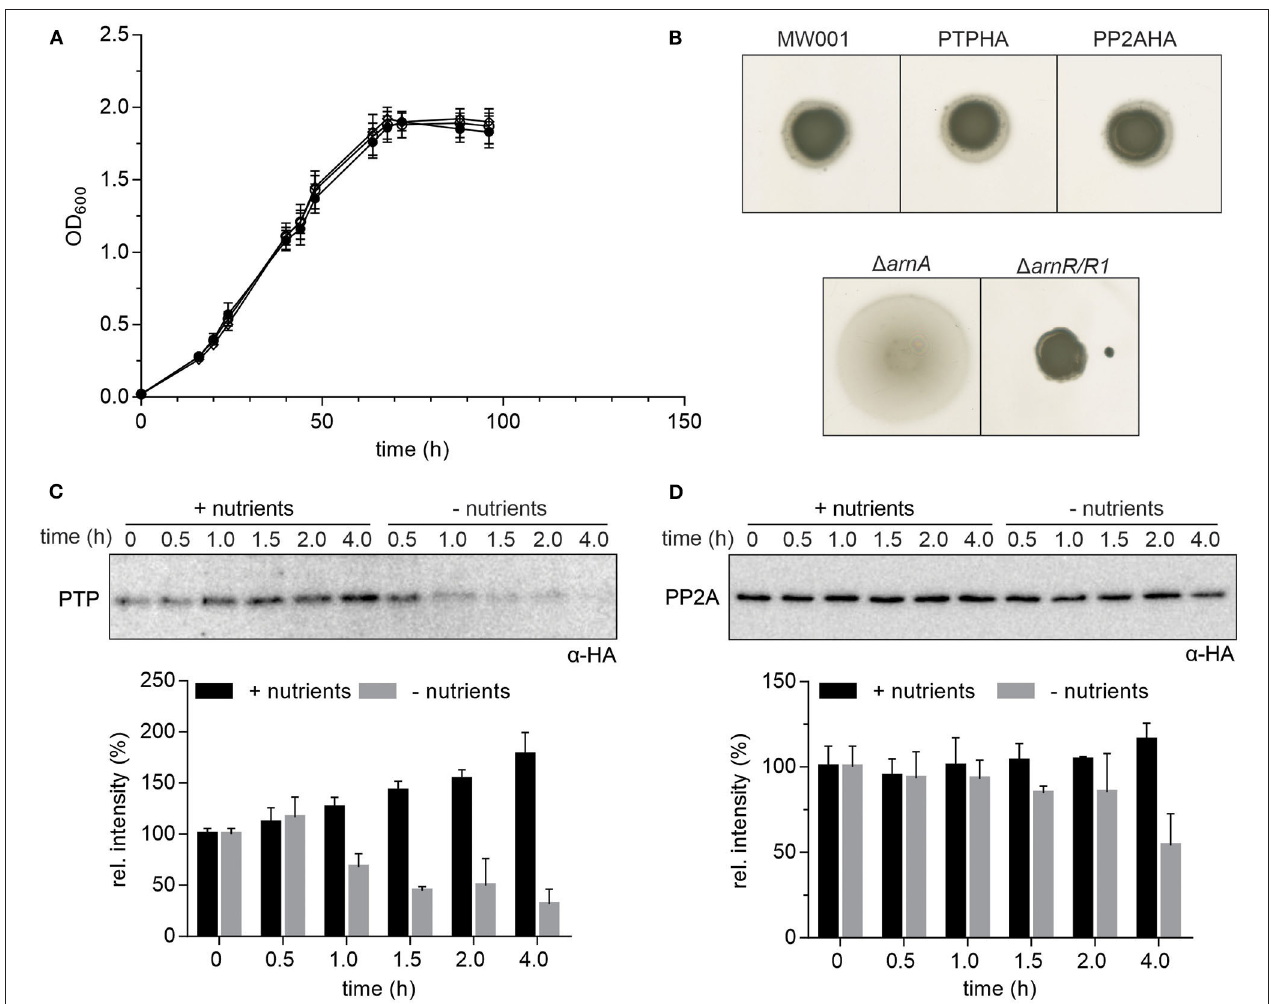
FIGURE 1 | Expression of HA-tagged PP2A and PTP. (A) Growth curves of S. acidocaldarius cells grown in nutrient rich medium at 75 ◦ C were obtained for the parental MW001 strain (black solid circle) and the stains containing HA-tagged PP2A (black open square) and PTP (black open circle). The OD 600 of each strain was measured at the indicated time points. The average of three independent experiments is shown. (B) For motility assays, exponentially growing S. acidocaldarius cultures of around OD 600 0.4 were spotted on semi-solid gelrite plates with 0.005% (w/v) NZ-amine and incubated at 75 ◦ C for 5 days before scanning the plates. The motility assays were repeated with three biological and six technical replicates. A representative experiment is shown. (C) Expression of HA-tagged PTP and (D) PP2A in S. acidocaldarius . PTPHA and PP2AHA mutants were grown in nutrient rich and starvation medium for 4h. Samples were collected at different time points (0, 0.5, 1.0, 1.5, 2.0, and 4.0h) and analyzed by Western blotting with α -HA. Representative Western blots are shown. A quantification of three independent experiments is shown below the